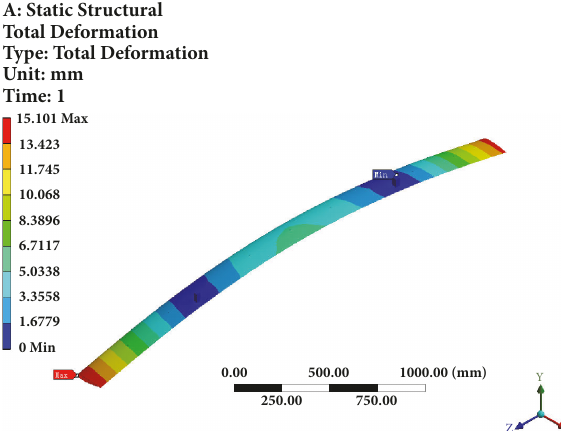
Figure 6: Displacement variation contour of main blade.